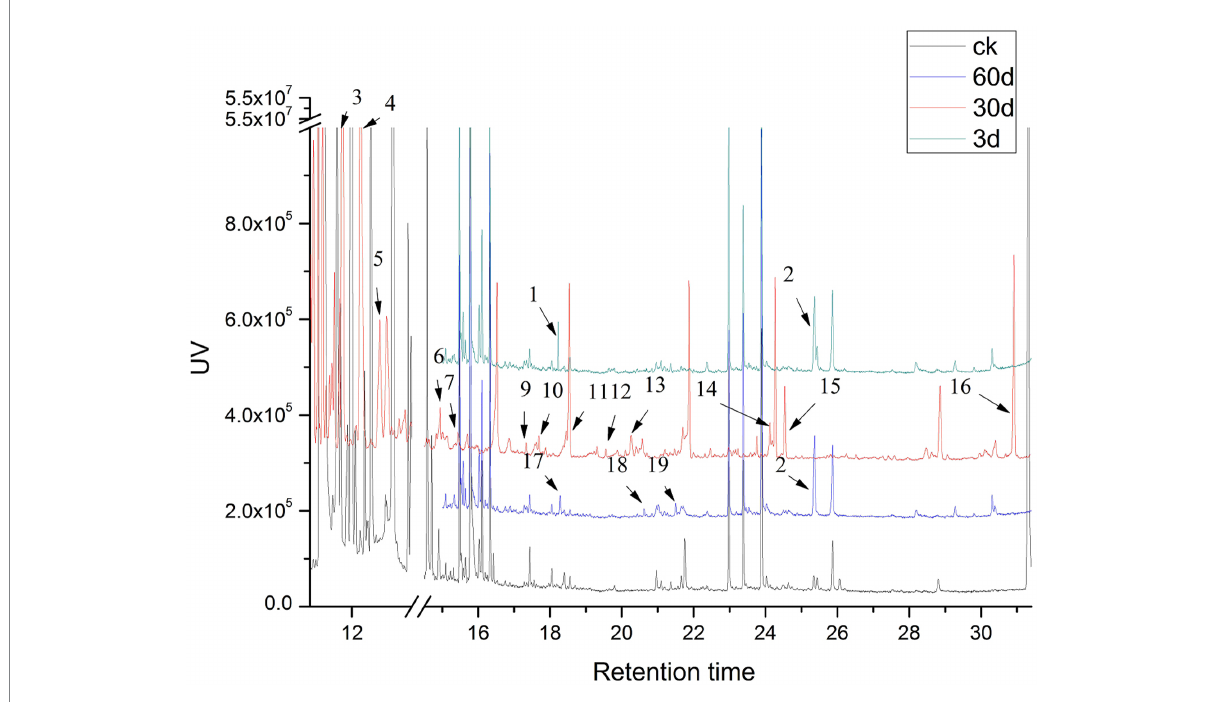
FIGURE 6 GC–MS analyses of lignin degradation compounds from samples collected 3, 30, and 60 days following